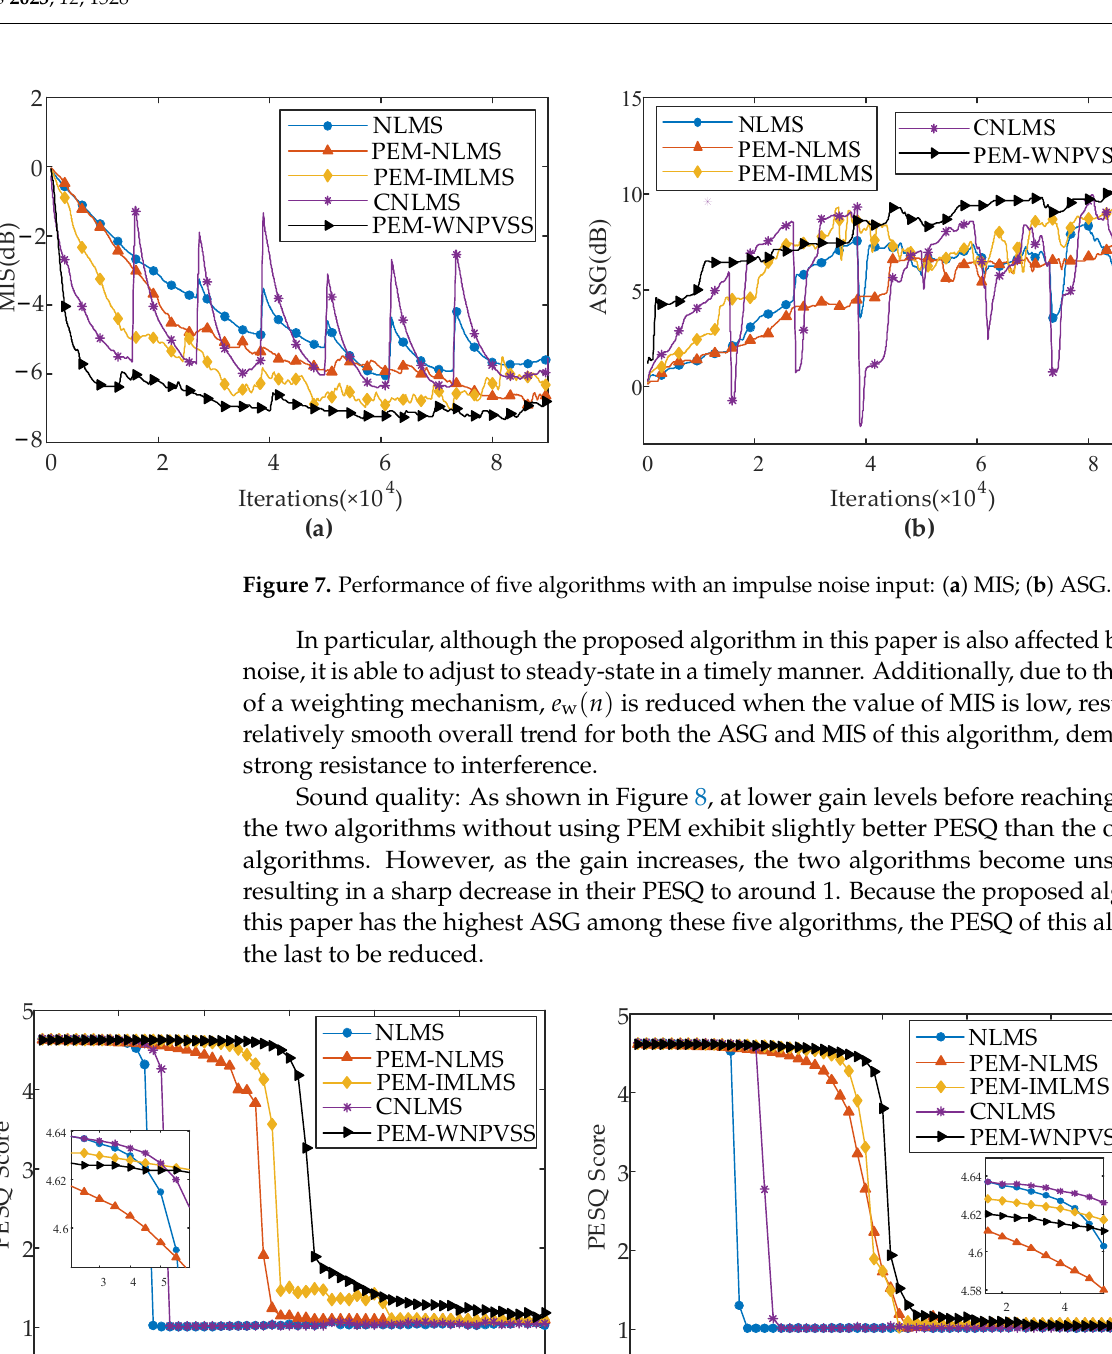
Figure 8. PESQ score of five algorithms when the inputs are: ( a ) speech; ( b ) music.